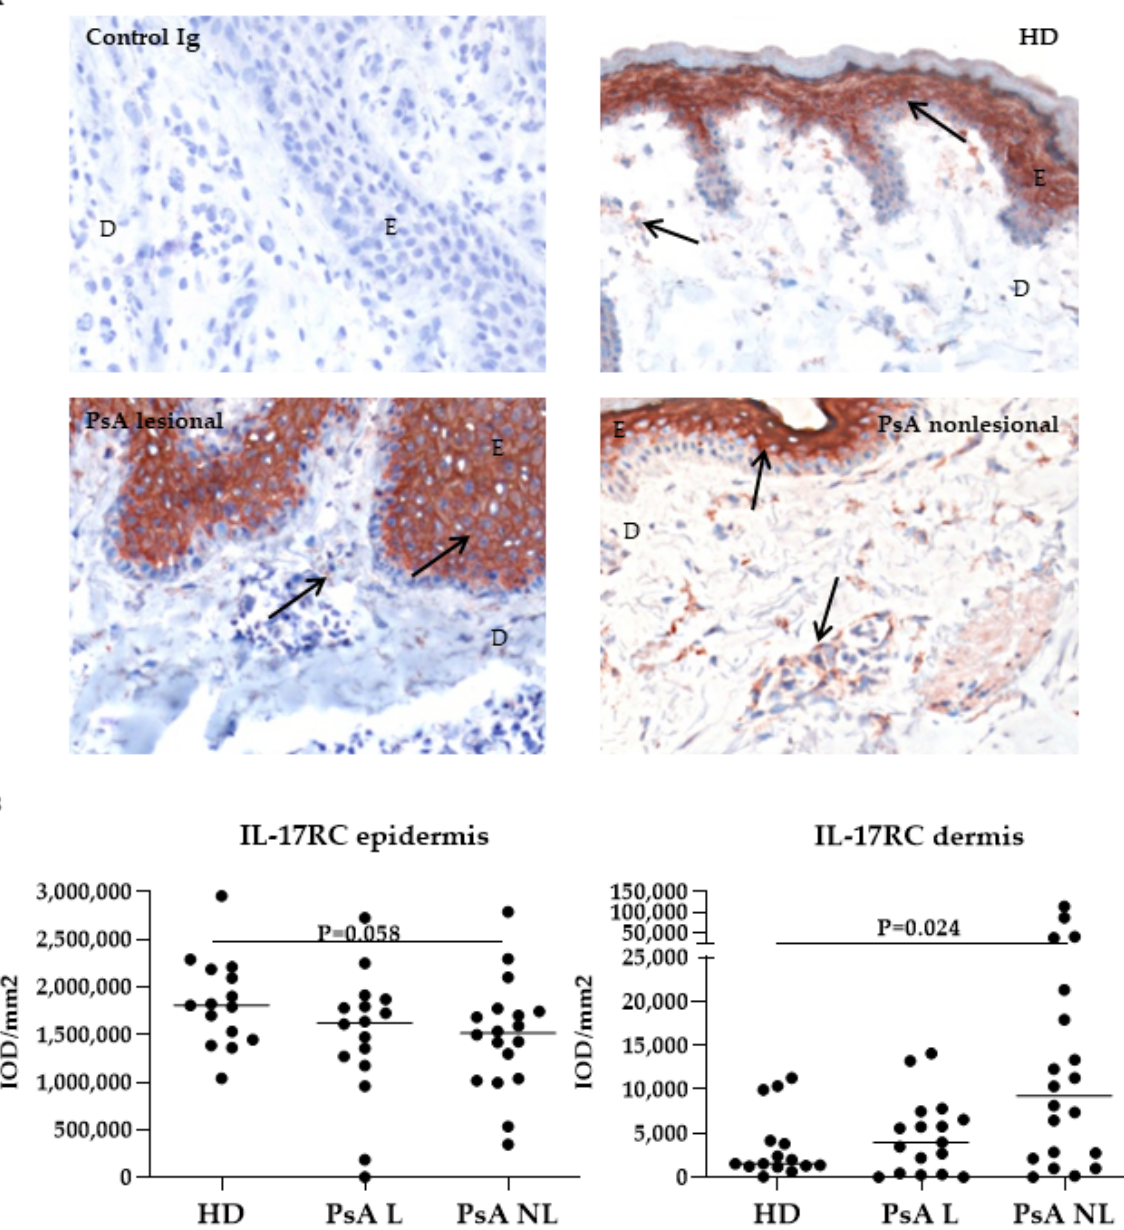
Figure 4. Expression of IL-17RC in psoriatic skin was higher in the dermis of nonlesional psoriatic skin compared to healthy donor skin. ( A ) Representative immunohistochemical staining of baseline IL-17RC expression (arrows) in skin from HD and PsA patients. Original magnification 200 × . ( B ) Quantification of IL-17RC (Kruskal-Wallis test, epidermis p = 0.13, dermis p = 0.03) expression in HD, PsA L skin and PsA NL skin. Results are shown as median IOD/mm 2 and IQR of epidermis and dermis of HD and PsA patients. Per subject the median expression level of 18 high-power fields is used for analysis. p values given in the graphs are calculated from a post Dunn’s test. E, epidermis; D, dermis, IL, interleukin; HD, healthy donor; PsA, psoriatic arthritis; L; lesional, NL; nonlesional, IOD; integrated optical density, IQR; interquartile range.